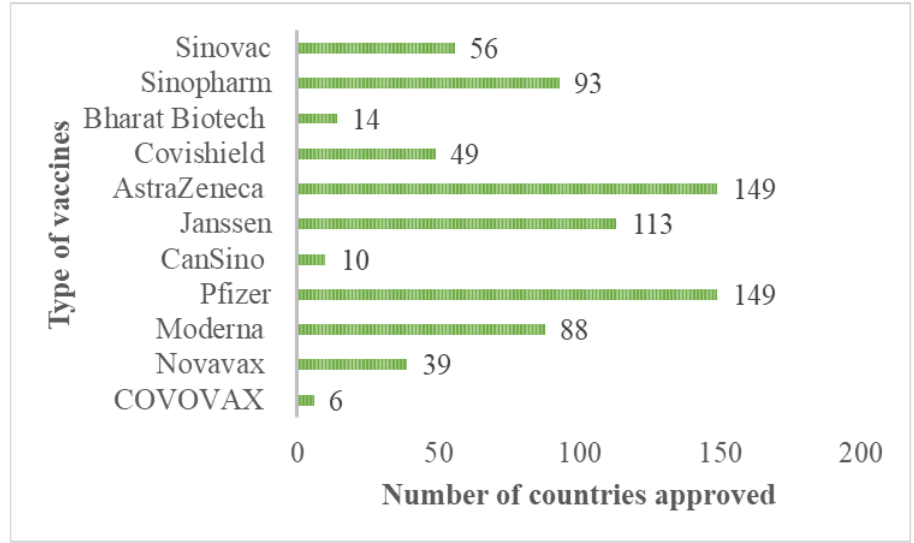
Figure 6. Type of vaccines approved by certain countries. According to C. Chambers in her articles published by Healthy Debate on 11 March